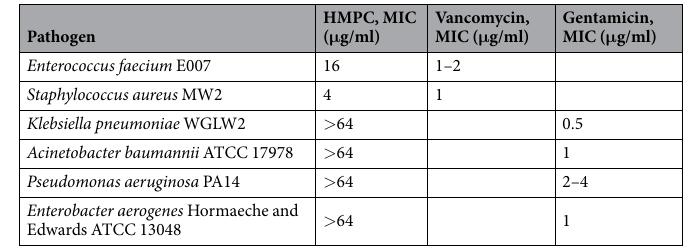
Table 2. Activity of HMPC against a panel of ESKAPE pathogens. Vancomycin and gentamicin were included for comparison